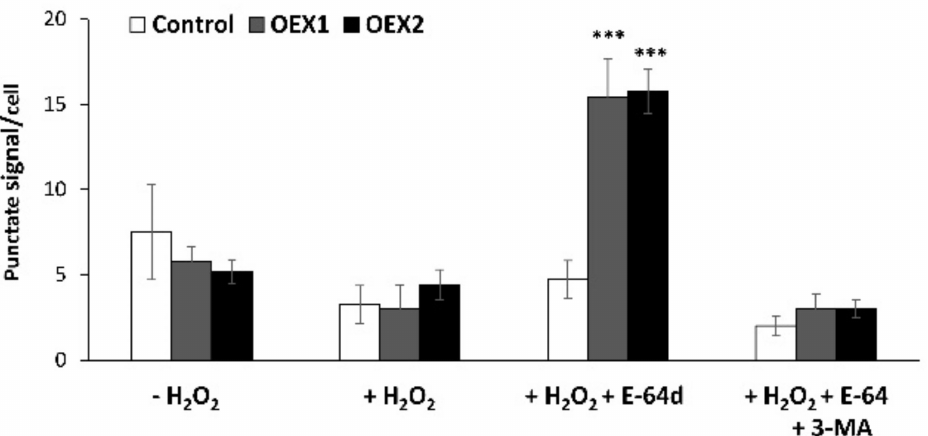
Figure 7. Quantification of ATG8 after immunofluorescence analysis. Number of immunofluorescent punctate signals per cell after immunodetection of ATG8 in Control and two overexpressing Pstrxo1 (OEX) tobacco BY-2 cells 24 h after treatment with 35 mM H 2 O 2 and in the presence of E-64d or E-64d plus 3-MA as described in Material and Methods. The asterisks *** indicate significant differences of each genotype compared to the H 2 O 2 -treated cells (+H 2 O 2 ), as seen from Student’s t -test ( p <